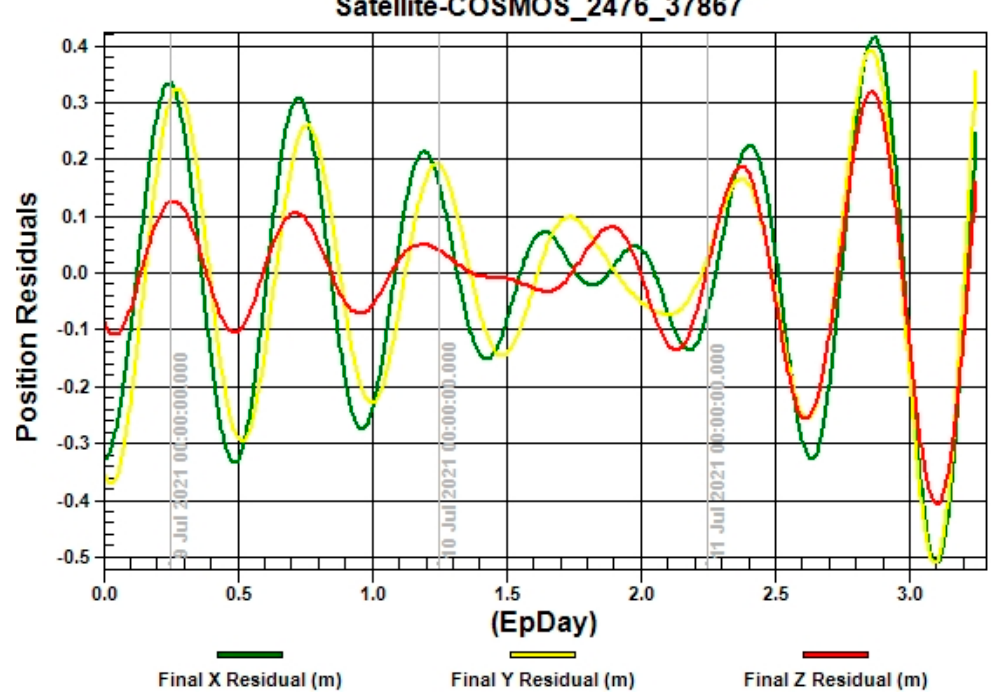
Figure 5. The relationship between the position residuals and the time for satellite “COSMOS-2476”.